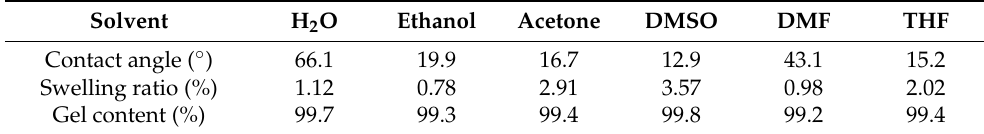
Table 3. Swelling rate, gel fraction and contact angle of VAN-AC-EP/DDM in different solvents.